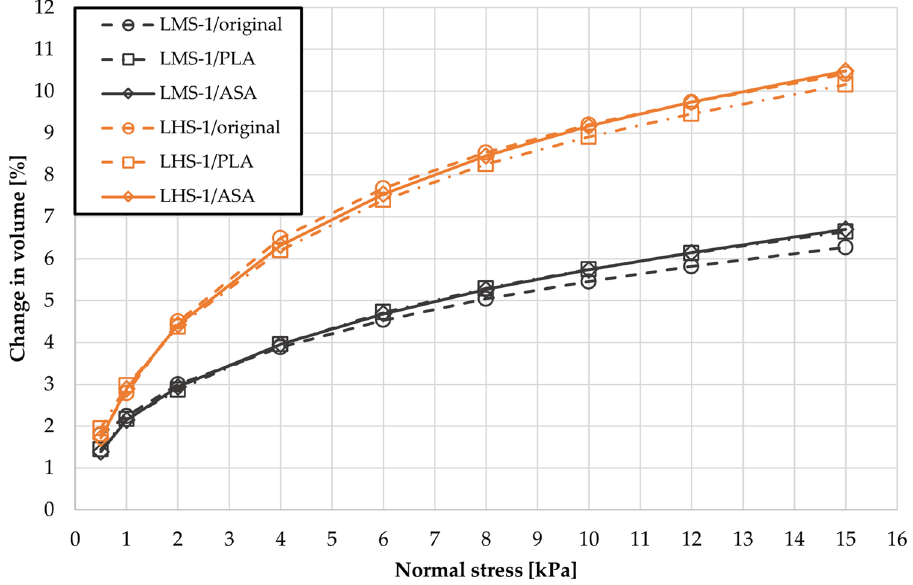
Figure 7. Compressibility of LMS-1 and LHS-1 powders measured by original, and 3D printed instruments.